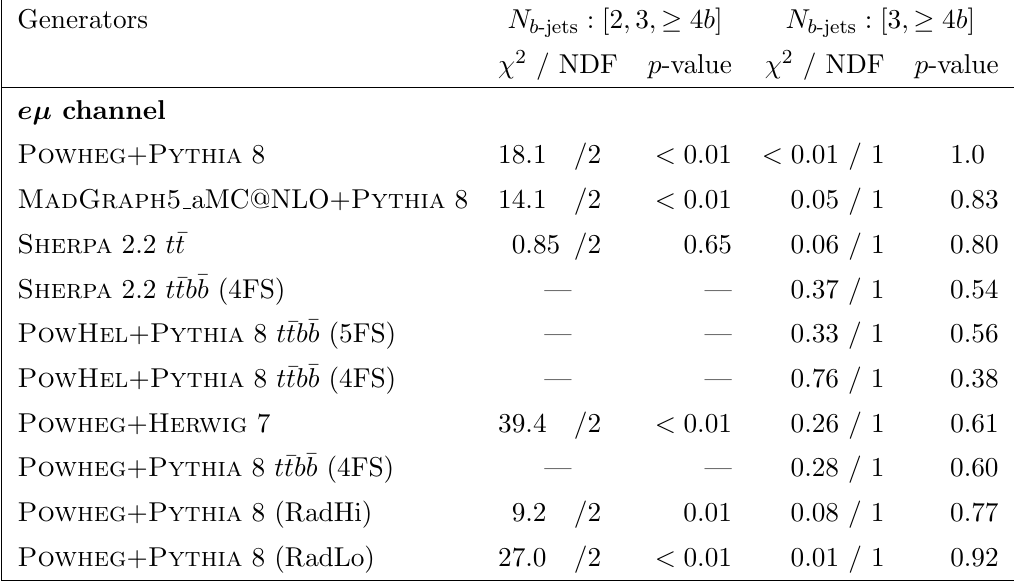
Table 7. Values of (cid:31) 2 per degree of freedom and p -values between the unfolded normalised cross- section and the predictions for b -jet multiplicity measurements in the e(cid:22) channel. The number of degrees of freedom is equal to the number of bins minus one. Calculations are performed after subtracting estimated contributions from t (cid:22) tH and t (cid:22) tV from the data. In the two right columns, data and predictions are normalised to cross-section for N b -jets (cid:21) 3 before calculating (cid:31) 2 per degree of freedom and p